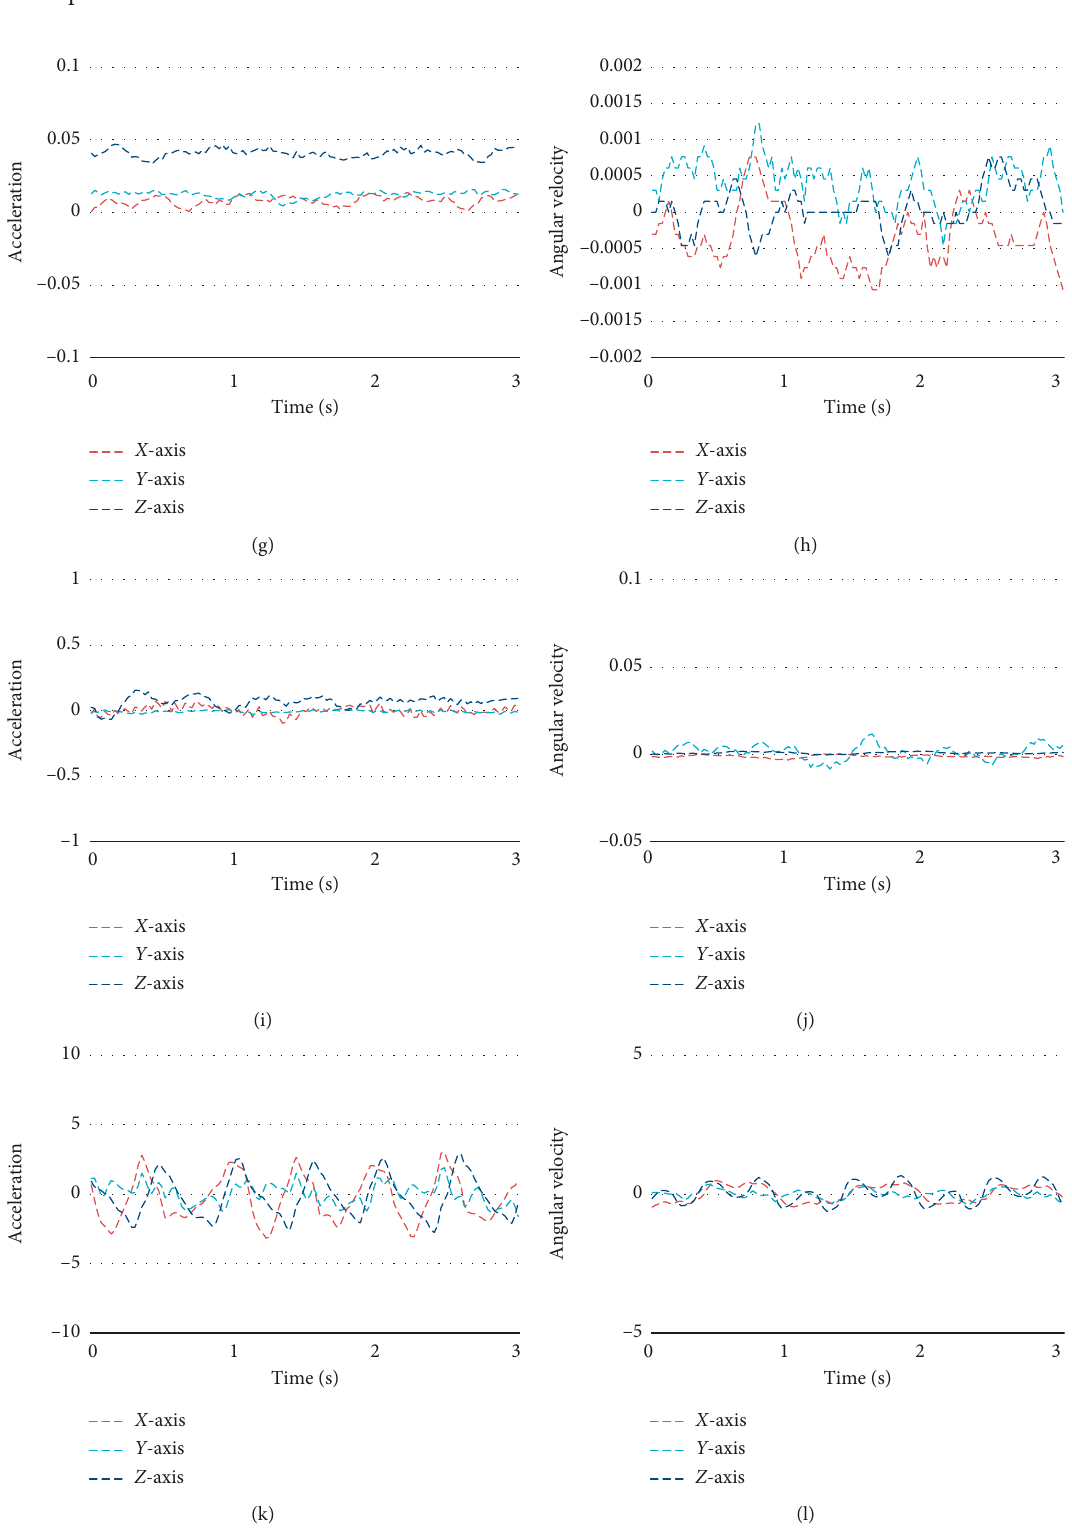
Figure 4: Signals of acceleration and angular velocity for six transport states: (a) acceleration and (b) angular velocity of BIC; (c) acceleration and (d) angular velocity of BUS; (e) acceleration and (f) angular velocity of RUN; (g) acceleration and (h) angular velocity of STI; (i) acceleration and (j) angular velocity of SUB; (k) acceleration and (l) angular velocity of